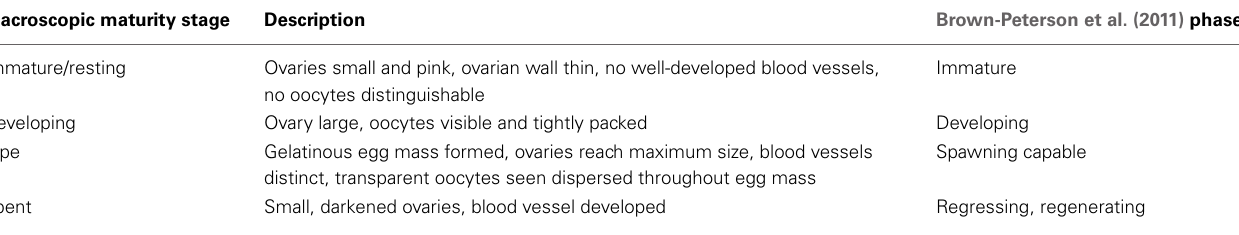
Table 1 | Macroscopically determined maturity stages for pre-fixation ovaries, adapted from Everson et al.